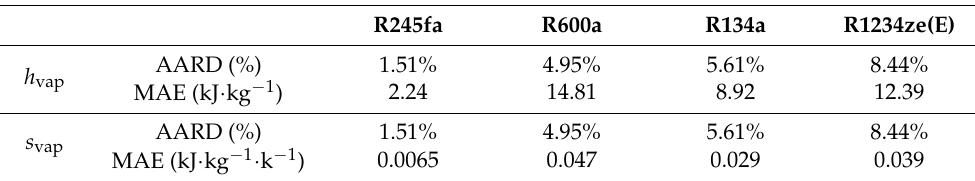
Figure 6. Comparison of h vap s vap at different temperatures: ( a ) R245fa; ( b ) R600a; ( c ) R134a; ( d ) R1234ze(E). Table 5. AARDs and MAEs of h vap and s vap